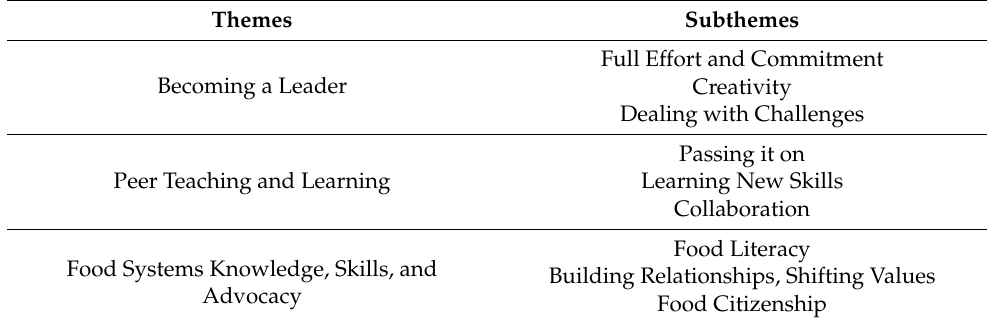
Table 4. Experiences described by Food Next Door (FND) in graduate student leads (n = 3) in year